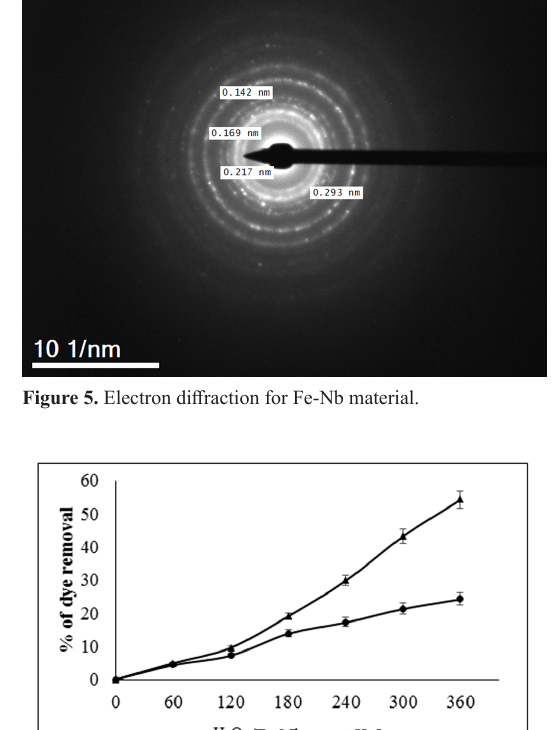
Figure 6. Percent of color removal of IC solutions by the H Fe-Nb and H